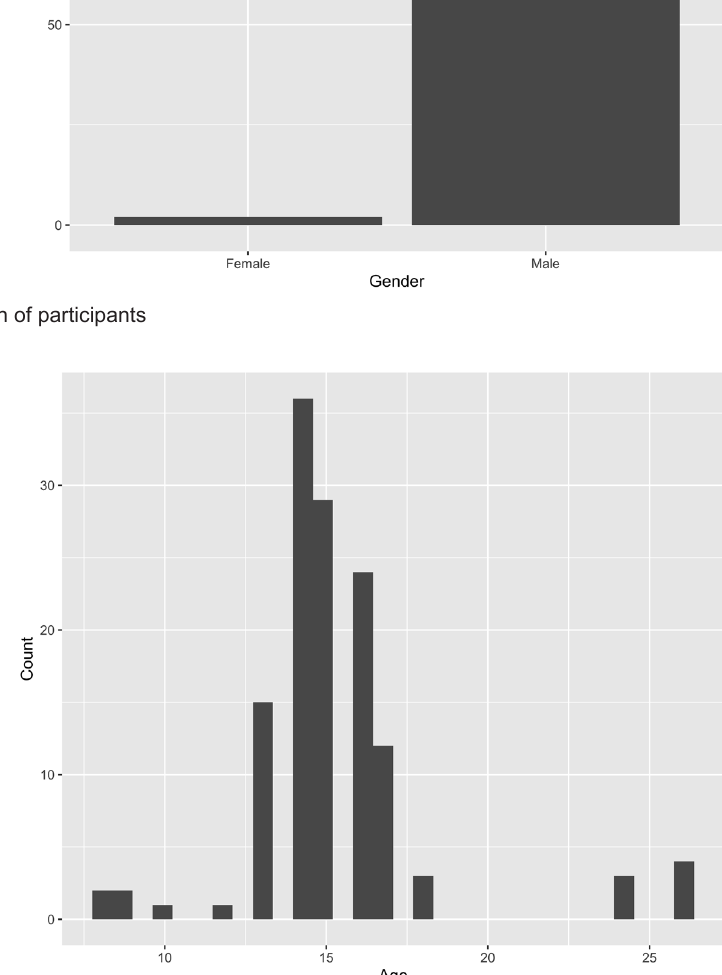
Figure 2. Age distribution of